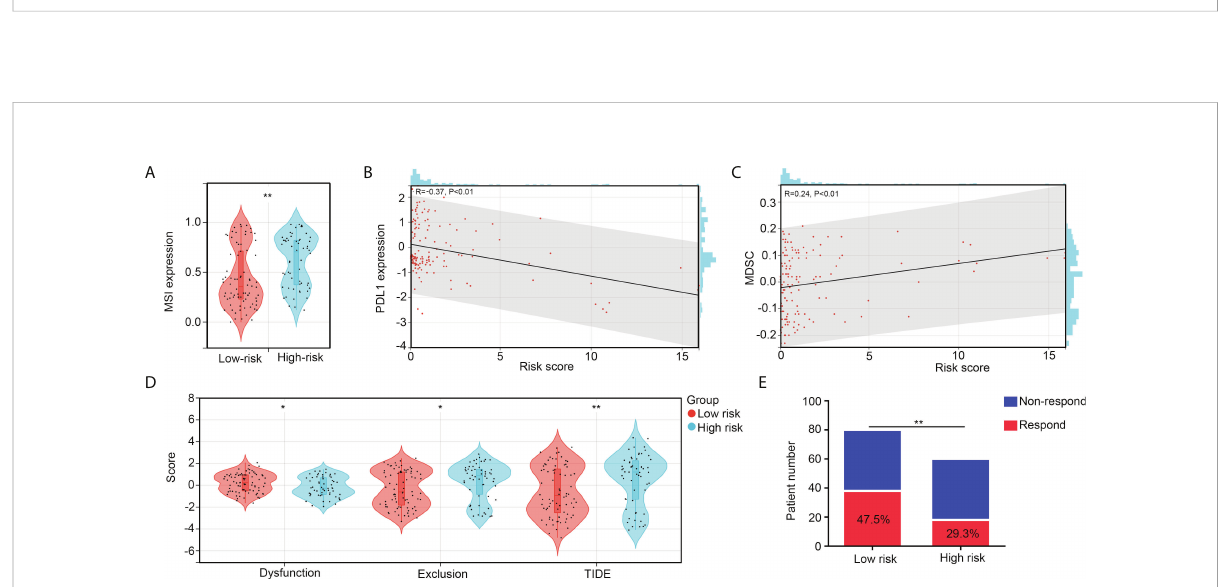
FIGURE 8 The high-risk group patients with OS exhibit resistance to ICB. (A) MSI scores between high- and low-risk group OS tissues. (B) Co-expression relationships between risk scores and PDL1 expression. (C) Co-expression relationships between risk scores and MDSC levels. (D) The difference of exclusion, dysregulation, and TIDE scores between high- and low-risk group OS tissues. (E) Predication of non-responder and responder numbers after ICB in high- and low-risk group OS tissues. *p < 0.05, **p <